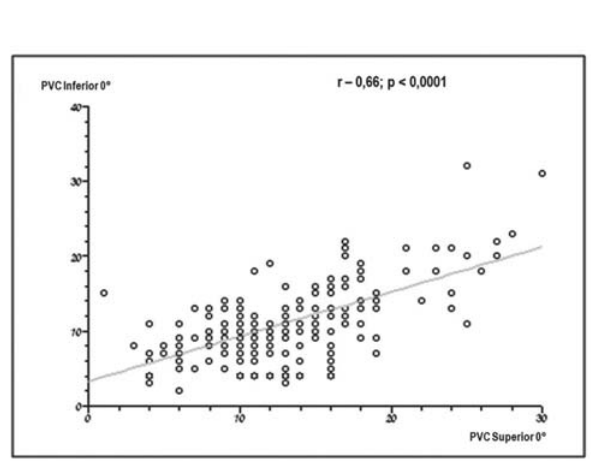
Fig.1 - Correlação linear entre PVC em sítio inferior e superior a zero grau. Gráfico mostrando correlação linear positiva entre as medidas de PVC em posição de zero grau da cabeceira do leito